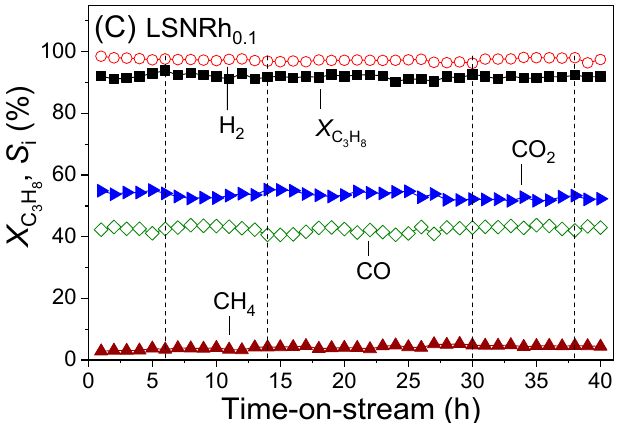
Figure 7. Long-term stability tests obtained at T = 600 ◦ C over the ( A ) LN, ( B ) LSN, and ( C ) LSNRh 0.1 catalysts. Experimental conditions: same as in Figure 3. Vertical lines indicate shutting down of the system overnight, where the catalyst was kept at room temperature under He flow.